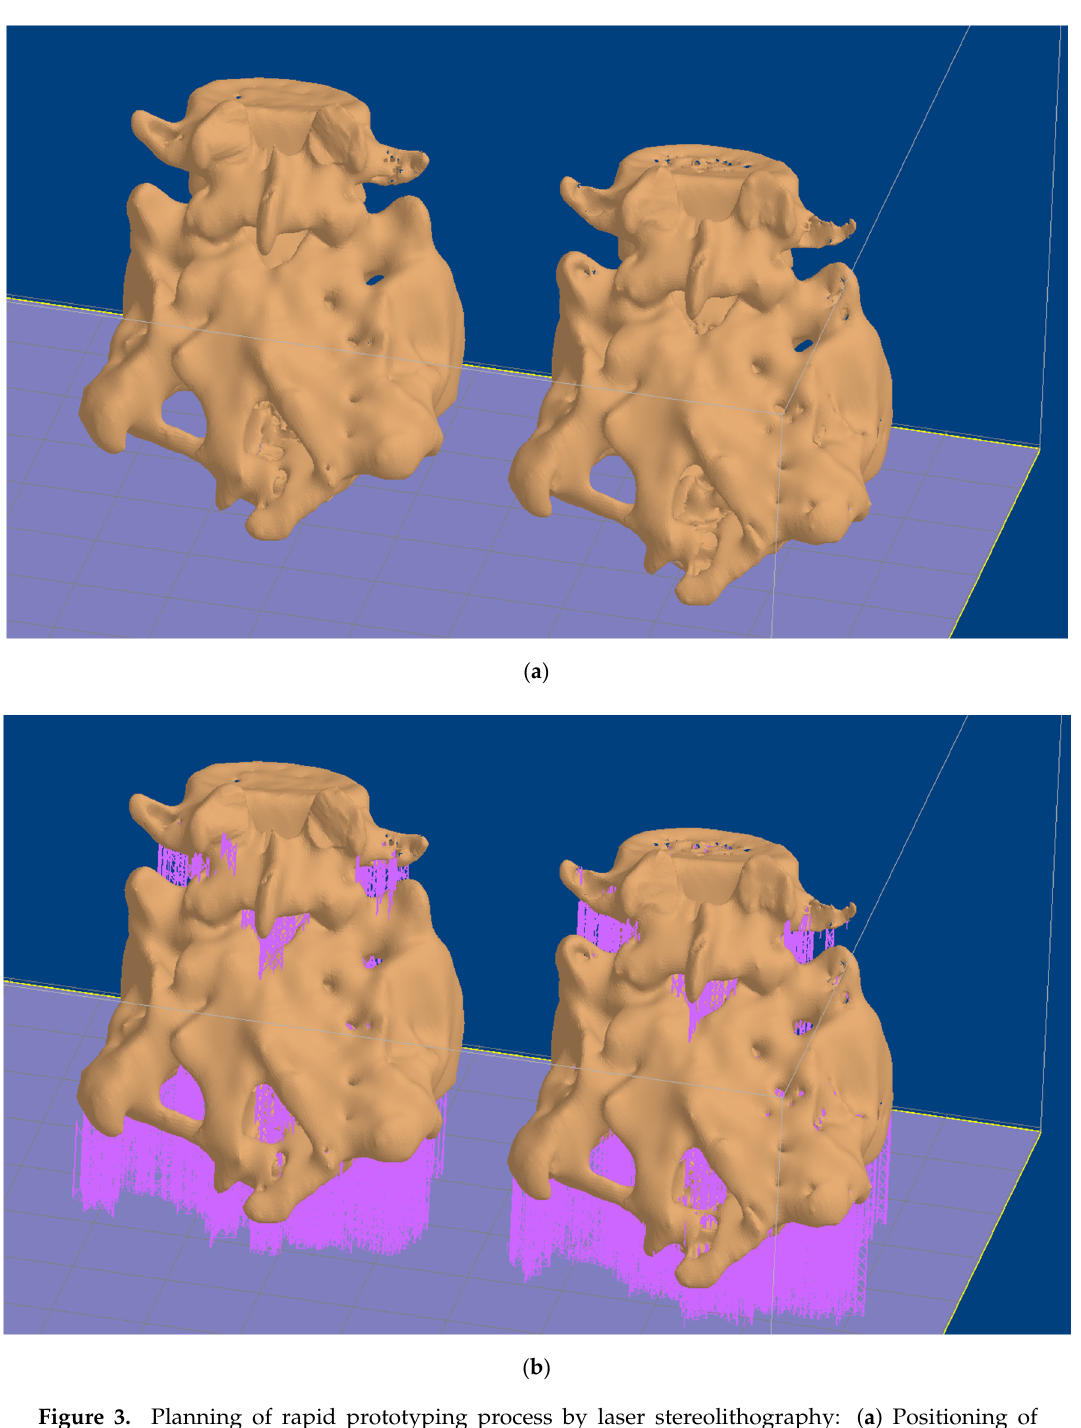
Figure 3. Planning of rapid prototyping process by laser stereolithography: ( a ) Positioning of alternatives in the construction platform. ( b ) Generated support structures. Scale bar: 90mm.